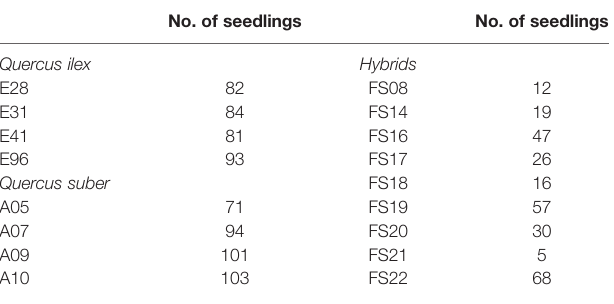
TABLE 1 | Number of seedlings in open-pollinated families, identi fi ed by the name of each mother tree. No. of